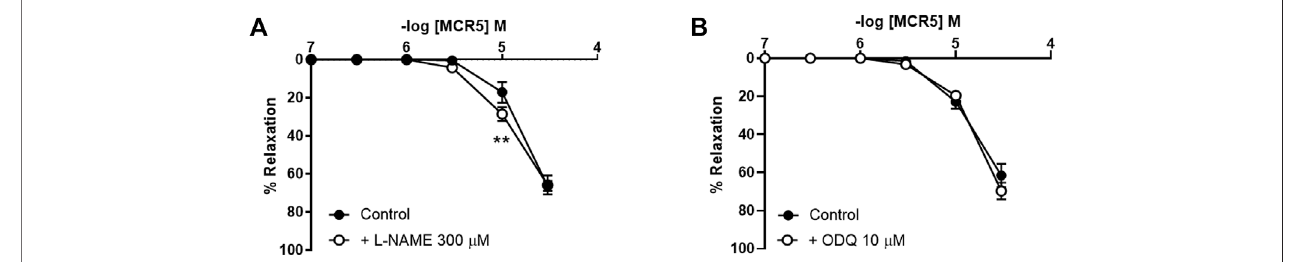
FIGURE 6 | Effects of NO pathway inhibition on MCR5 relaxations. Concentration-response curves to MCR5 in U46619-pre-contracted aortic rings from young OF1 mice in the absence (control) or presence of the NO synthase inhibitor L-NAME (300 µM) (A) or the soluble guanylyl cyclase inhibitor ODQ (10 µM) (B) . Results are mean ± SEM from n = 7 (A) and 5 (B) mice. pp p < 0.01 by two-way repeated measures ANOVA with Bonferroni ’ s post hoc test.